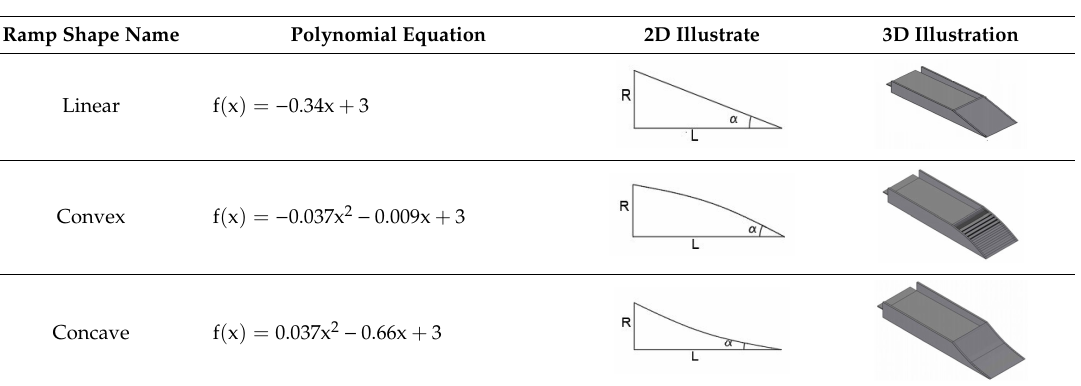
Figure 5. ( a ) Positive curvature shape. ( b ) Negative curvature shape. Table 2. Ramp shape in polynomial equation